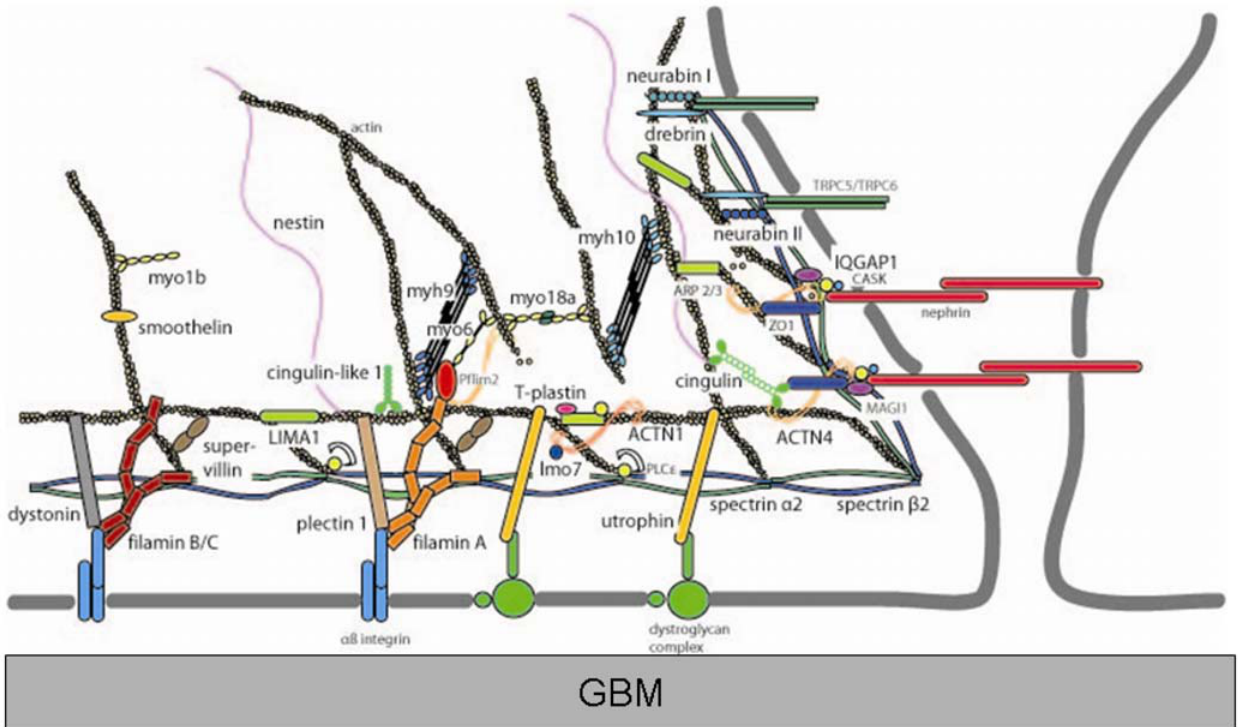
Figure 5. Schematic representation of a hypothesized podocyte protein ‘‘interactome’’ encoded by enriched mRNAs. Large black type indicates proteins encoded by mRNAs identified in this study. Smaller grey type is used to indicate several known podocyte foot process proteins in order to orient the figure. The interactions shown represent published results showing either direct interactions or presence in common protein complexes.